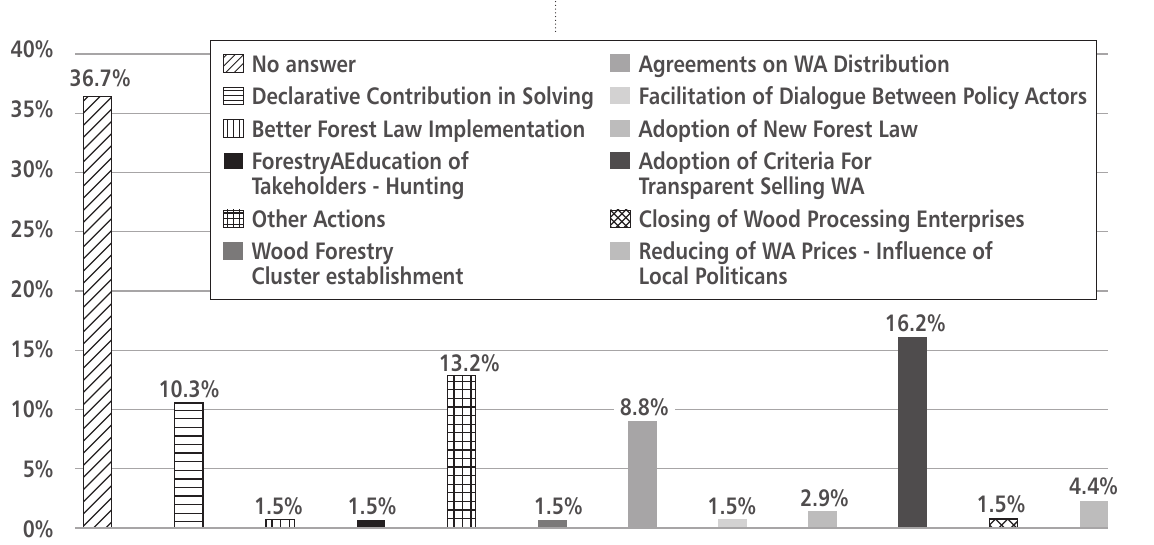
FIGURE 7 Actions done from policy makers in order to manage